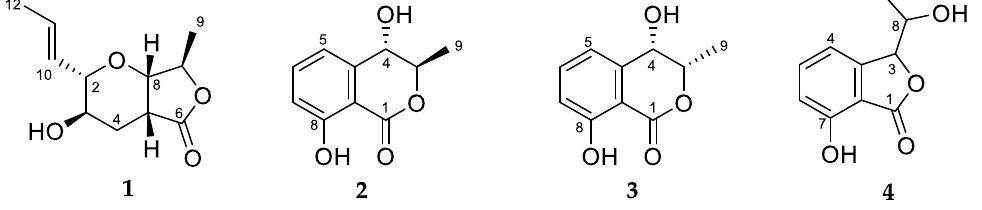
Figure 1. Structures of natural products 1 – 4 .